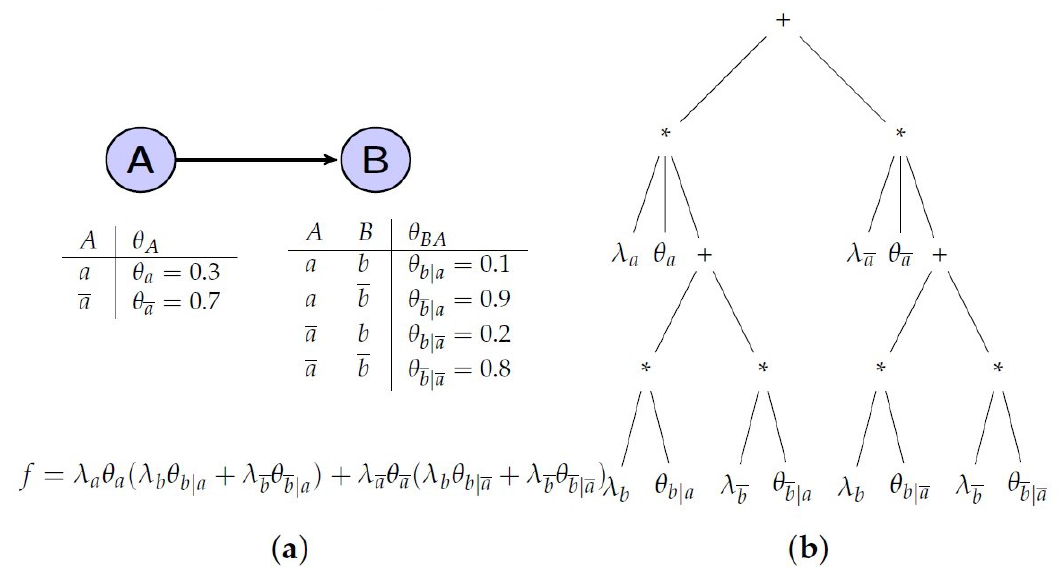
Figure 13. ( a ) A simple BN represented by a multilinear function f . ( b ) The corresponding Arithmetic Circuit of the BN.